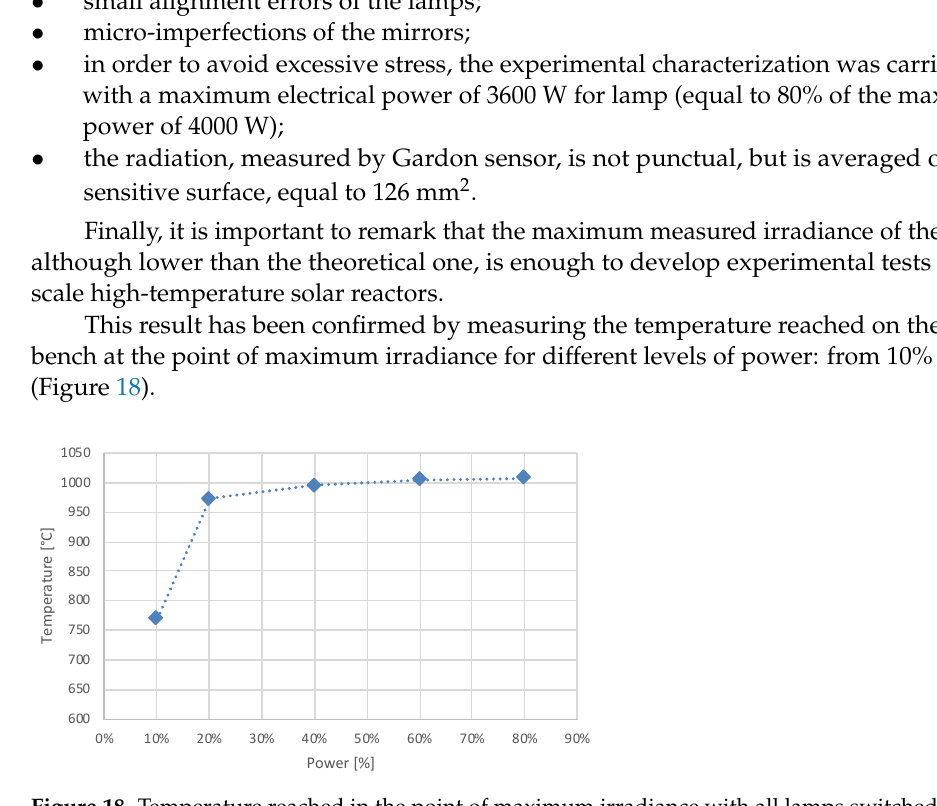
Figure 18. Temperature reached in the point of maximum irradiance with all lamps switched on as a function of power.